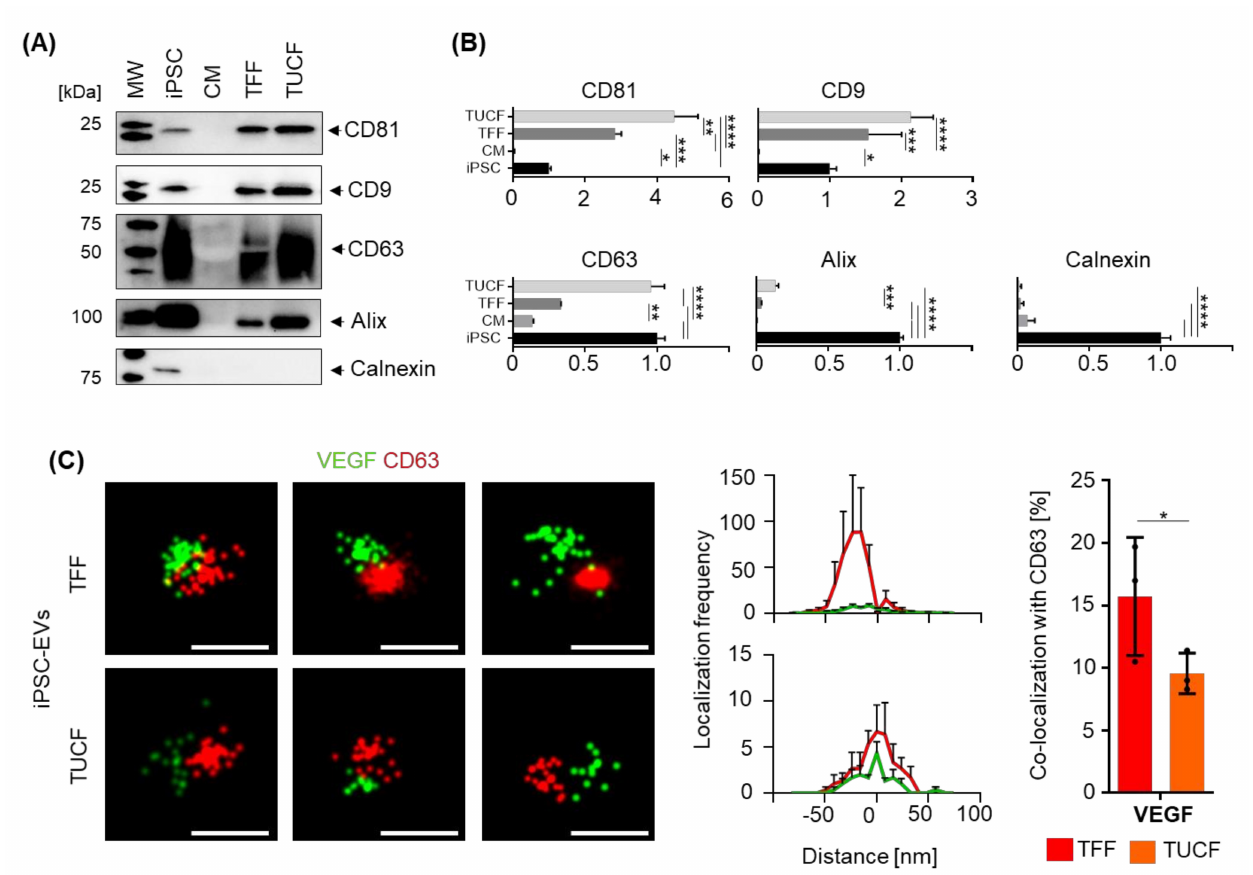
Figure 3. Characterization iPSC-EVs. ( A ) Human iPSC EVs in conditioned medium (CM), after enrichment by tangential flow filtration (TFF), and sub-sequent ultracentrifugation (TUCF) were compared to their parental iPSCs by immunoblotting for tetraspanins CD81, CD9 and CD63, for the EV marker alix and the cell-compartment contamination marker calnexin. Representative Western blots of two independent experiments. ( B ) Quantification of band intensity normalized to total protein loaded. Bars represent results from three independent replicates (**** p < 0.0001, *** p < 0.001, ** p < 0.01, * p < 0.05). ( C ) Representative super-resolution microscopy images of TFF- vs. TUCF-enriched iPSC-EVs showing co-localization of VEGF (green), and CD63 tetraspanins (red) as indicated. Scale bar 100 nm. Significantly more VEGF signal co-localization was determined on CD63 tetraspanin-labeled iPSC-EVs isolated by TFF than after TUCF as